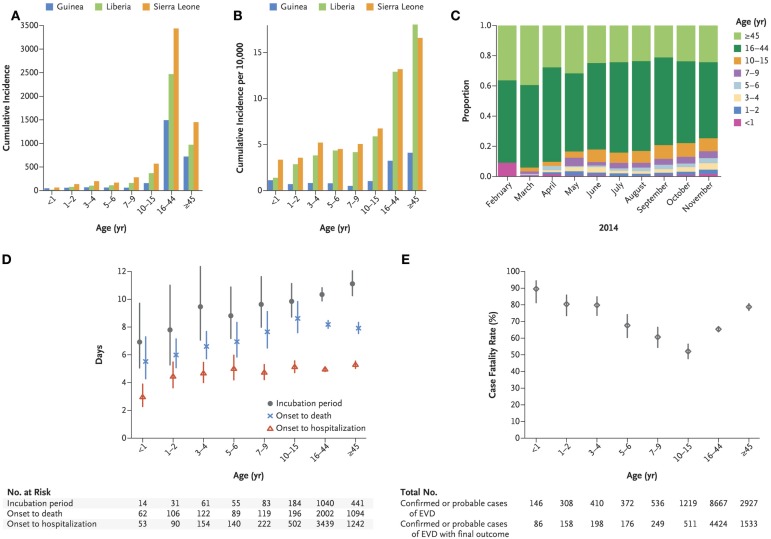
Age-group-specific incidence of Ebola virus disease in West Africa, incubation period, intervals from onset to death and onset to hospitalization, and case fatality rate. (A) shows the cumulative incidence of confirmed and probable cases of Ebola virus disease (EVD) according to age group and country. (B) shows the cumulative incidence of confirmed and probable cases per 10,000 population according to age group and country. (C) shows the overall age distribution for confirmed and probable cases according to month of symptom onset. (D) shows the estimated average incubation period, the interval between symptom onset and death, and the interval between symptom onset and hospitalization according to age among persons with confirmed or probable EVD [with vertical lines indicating 95% confidence intervals (CIs)]. The numbers represent the sample sizes in each age group. (E) shows the estimated case fatality rate according to age among persons with confirmed or probable EVD (with 95% CIs), with representation of the total number of confirmed or probable cases of EVD cases in each age group and the total number of confirmed or probable cases of EVD for which there was information on the final outcome in each age group. Copied with permission from: WHO Ebola Response Team, et al. (11)